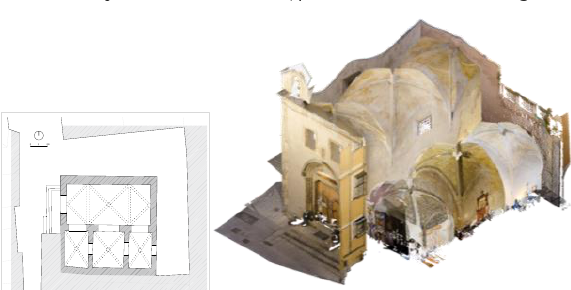
Figure 6 . Hybrid visualisation of BIM model of the ribs and the bosses inserted in the point cloud (left), and a comparison between synthetic BIM model, point cloud and mesh (right).